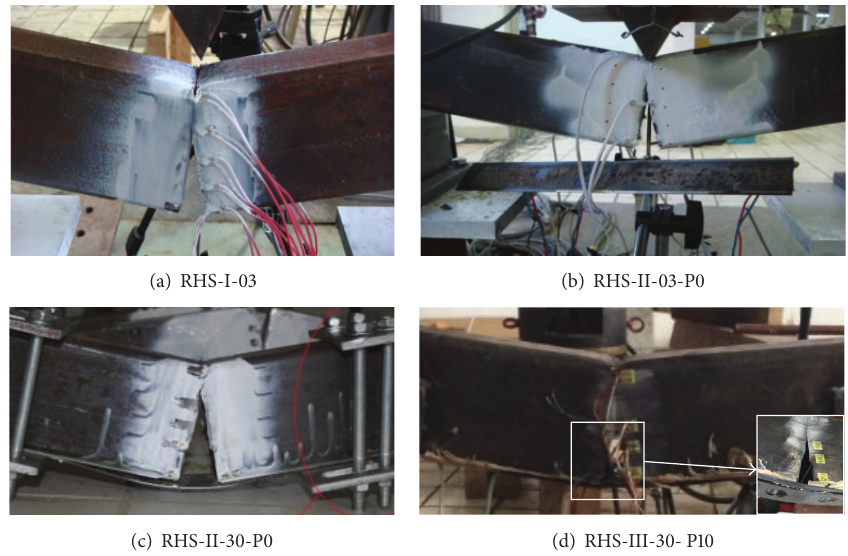
Figure 4: Failure patterns of the tested specimens.